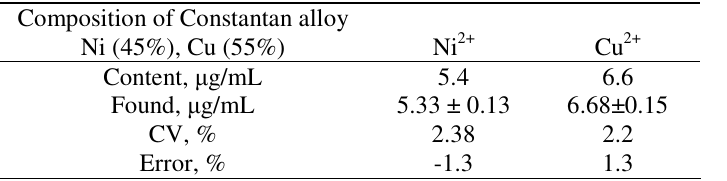
Table 5. Determination of nickel and copper in Constantan alloy